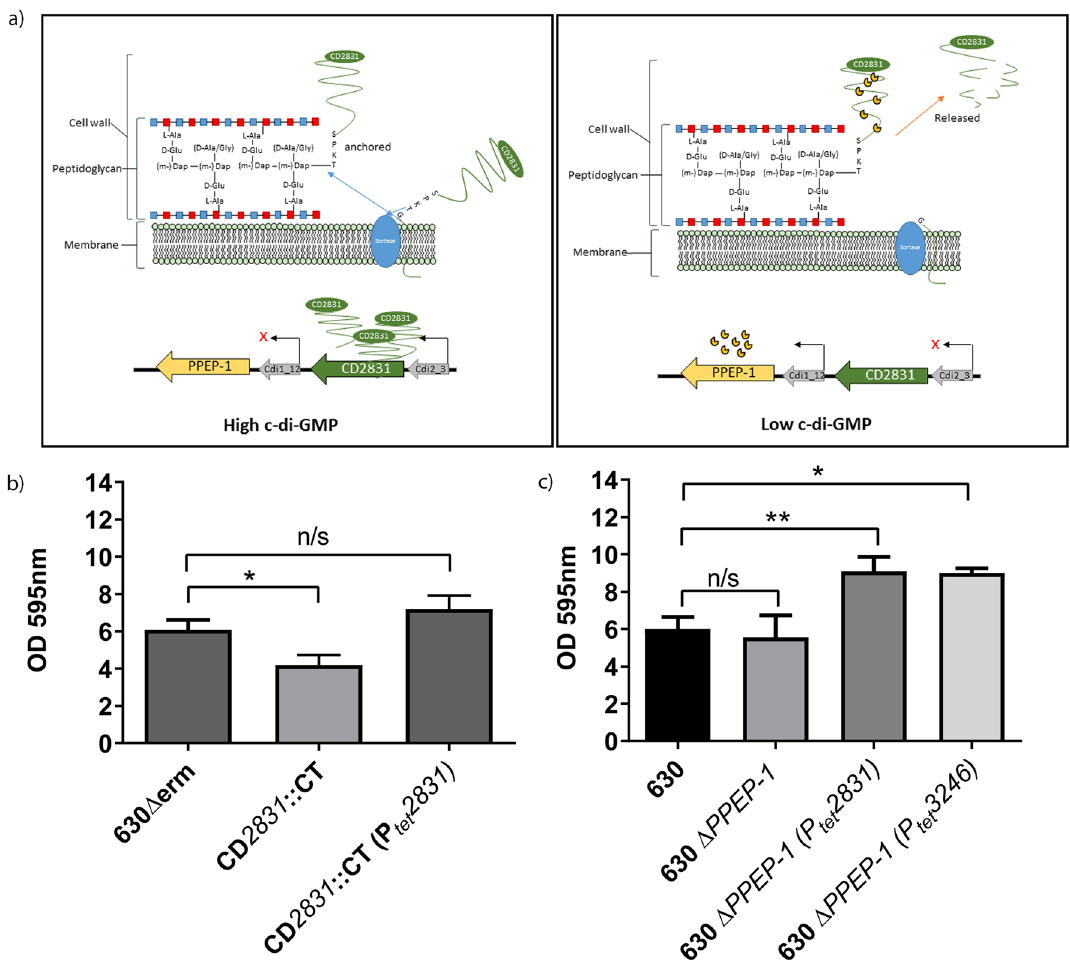
Figure 4. The effect of c-di-GMP regulated cell wall proteins on biofilm formation for C. difficile strain 630. ( a ) Schematic showing the sortase-dependent anchoring of CD2831 to the peptidoglycan of C. difficile . Under high levels of c-di-GMP, CD2831 is expressed by the permissive interaction of c-di-GMP with the upstream type II riboswitch (Cdi2_3). The protease PPEP‑1 is repressed under high levels of c-di-GMP due to the upstream type I riboswitch (Cdi1_12). Under low levels of c-di-GMP, expression of CD2831 is repressed and PPEP‑1 is upregulated, resulting in the cleavage of CD2831 (and CD3246) from the peptidoglycan and release into the supernatant. This scheme is based on published data 49,55,56 . ( b ) Crystal violet quantification of early biofilm formation produced in 24 well plates with an insertional inactivation mutant of CD2831 compared to its wildtype and inducible CD2831 complement under control of anhydrotetracycline (ATc). ( c ) Crystal violet quantification of early biofilm formation produced in 24 well plates with overexpression of CD2831 and CD3246 under the control of an ATc inducible promoter, in an in-frame deletion mutant of the protease PPEP‑1 . Crystal violet assays were performed with a minimum of 6 biological replicates. Error bars are SD. Significant differences are calculated using linear regression analysis compared to all strains against its respective parent strain 630Δ erm or 630, *p < 0.05, **p <